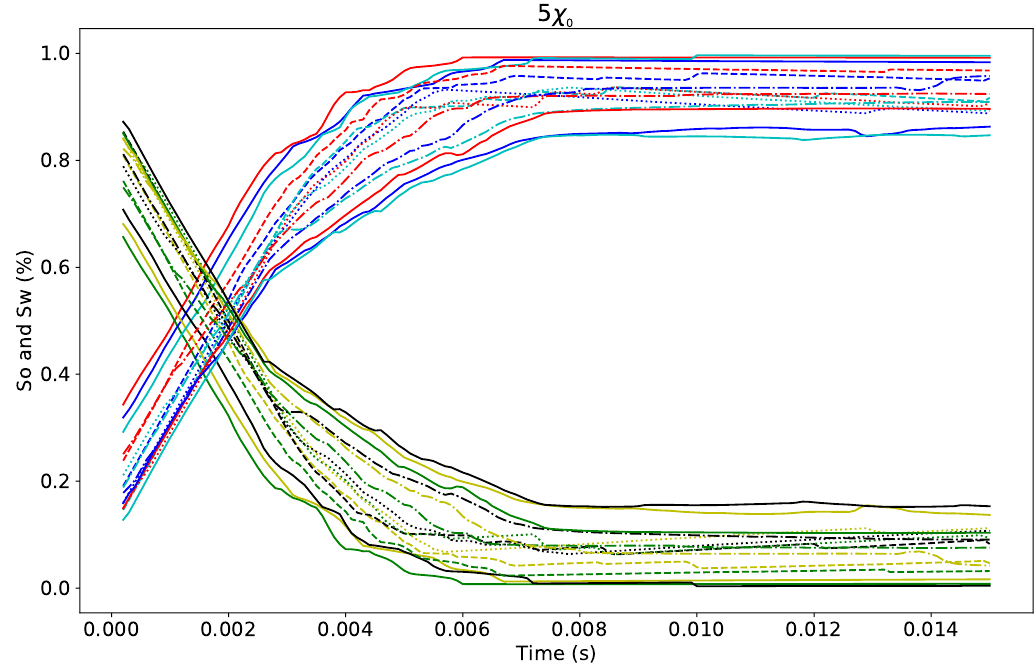
Figure 16. Effect of the wettability on both S or and Sw on non-Newtonian fluid with contact angle ranging from 10 to 150 ◦